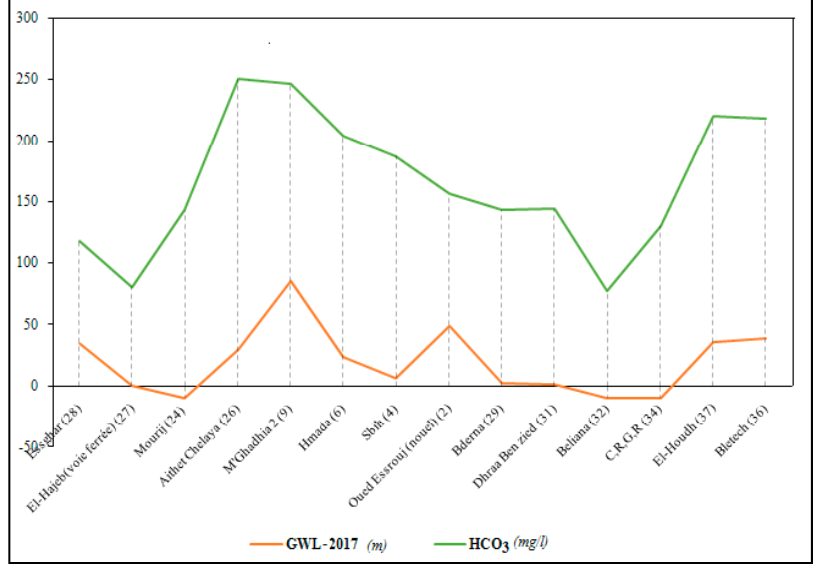
Figure 4. Correlation piezometric on HCO 3 spatial evolution in 2017 in the coastal shallow aquifer of